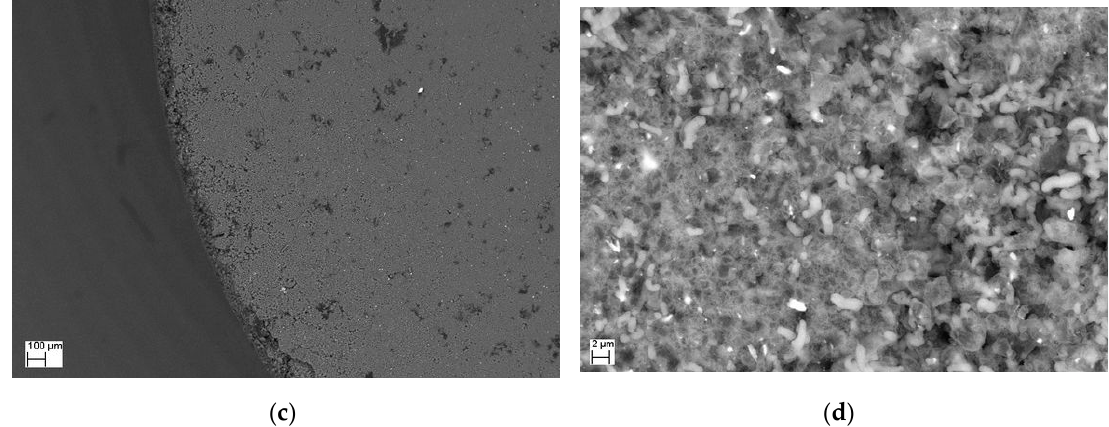
Figure 5. SEM images obtained by direct observation of the MgH 2 –5Fe–5ENG pellets after 20 ( a , b ) and 45 cycles ( c , d ) at different magnifications.